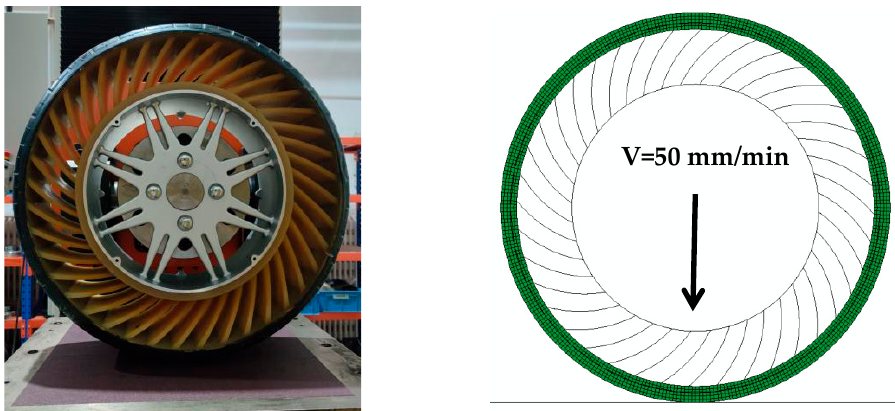
Figure 10. Finite-element model of the uniform-thickness NPT.